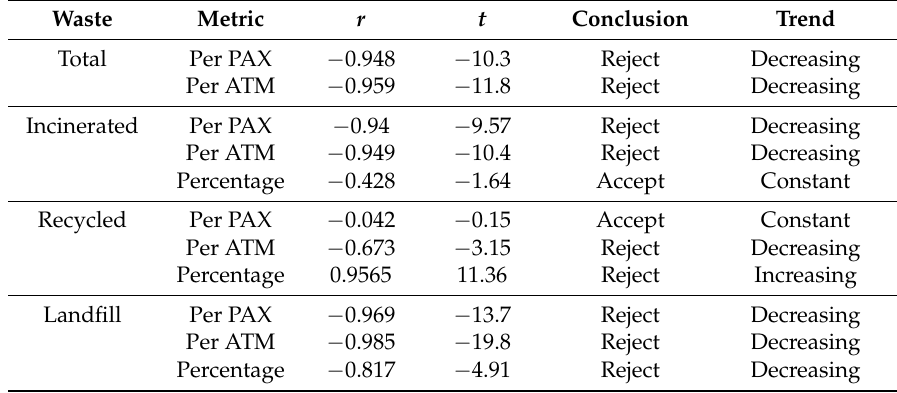
Table 5. Correlation assessment of waste parameters for various efficiency measures, all testing at the 99% confidence level, with 12 degrees of freedom, using a one-tailed test, with t crit =